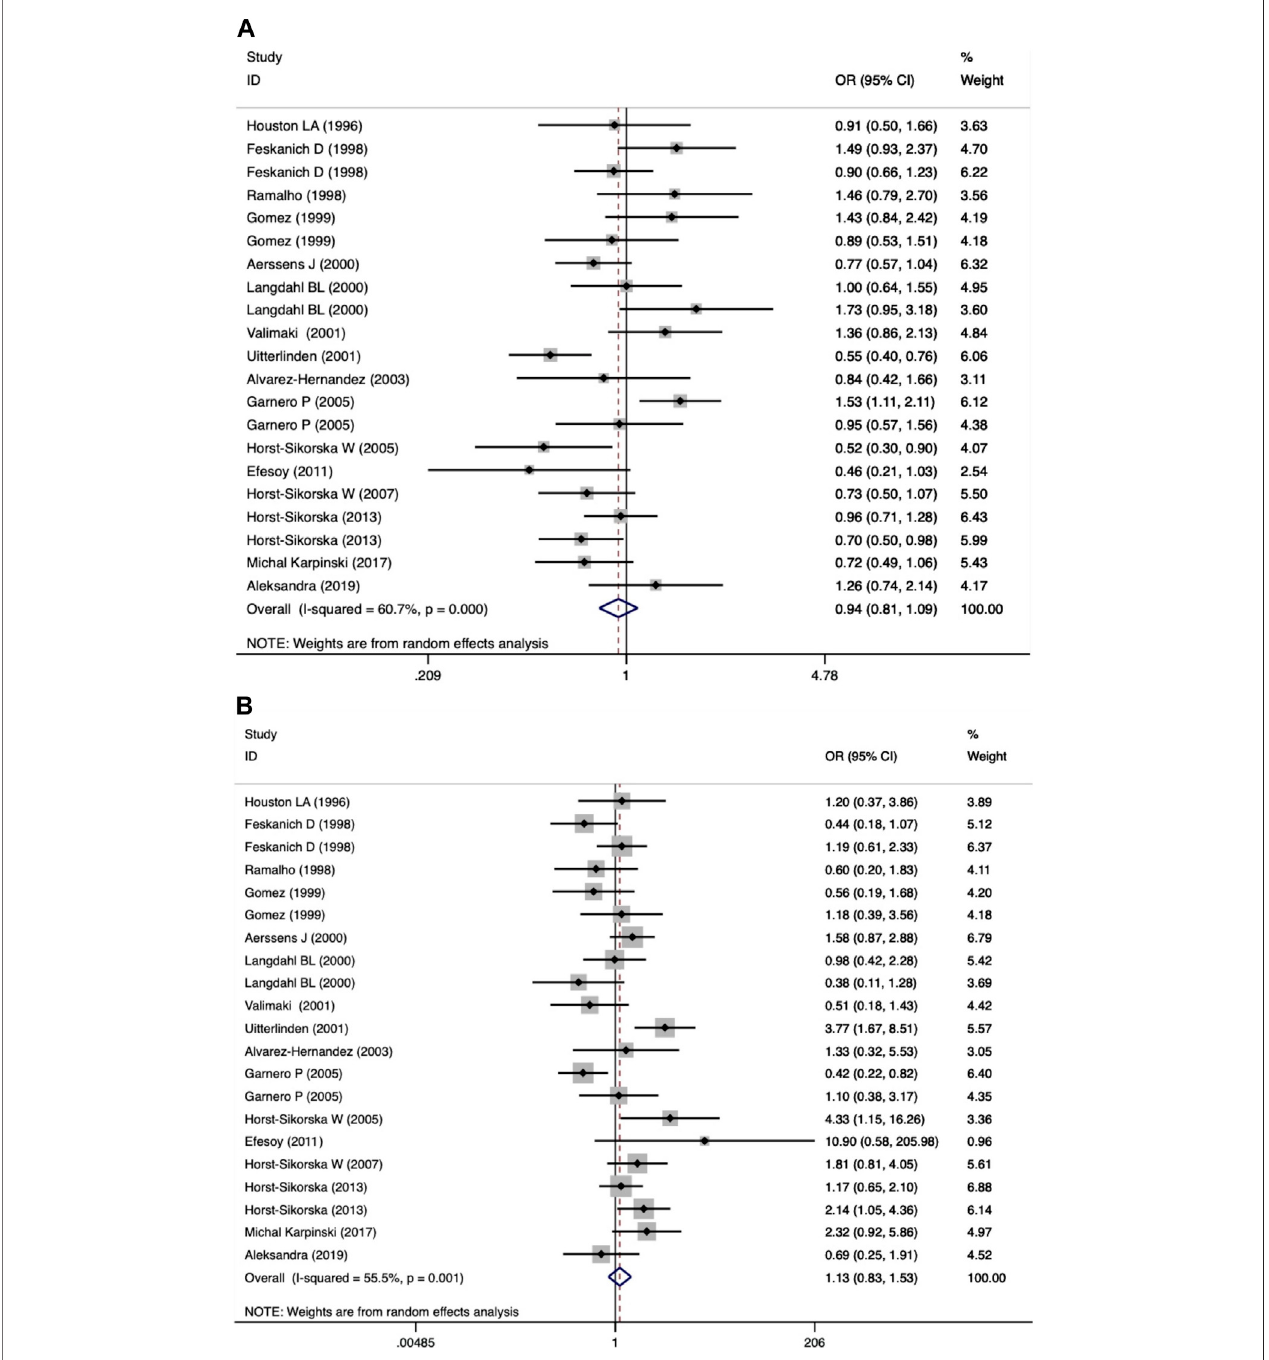
FIGURE2| ForestplotsofallselectedstudiesontheassociationbetweenVDRBsmlpolymorphismandtheriskofosteoporoticfractureindifferentraces[ (A) allele model, (B) additive model, (C) dominant model, and (D) recessive model].